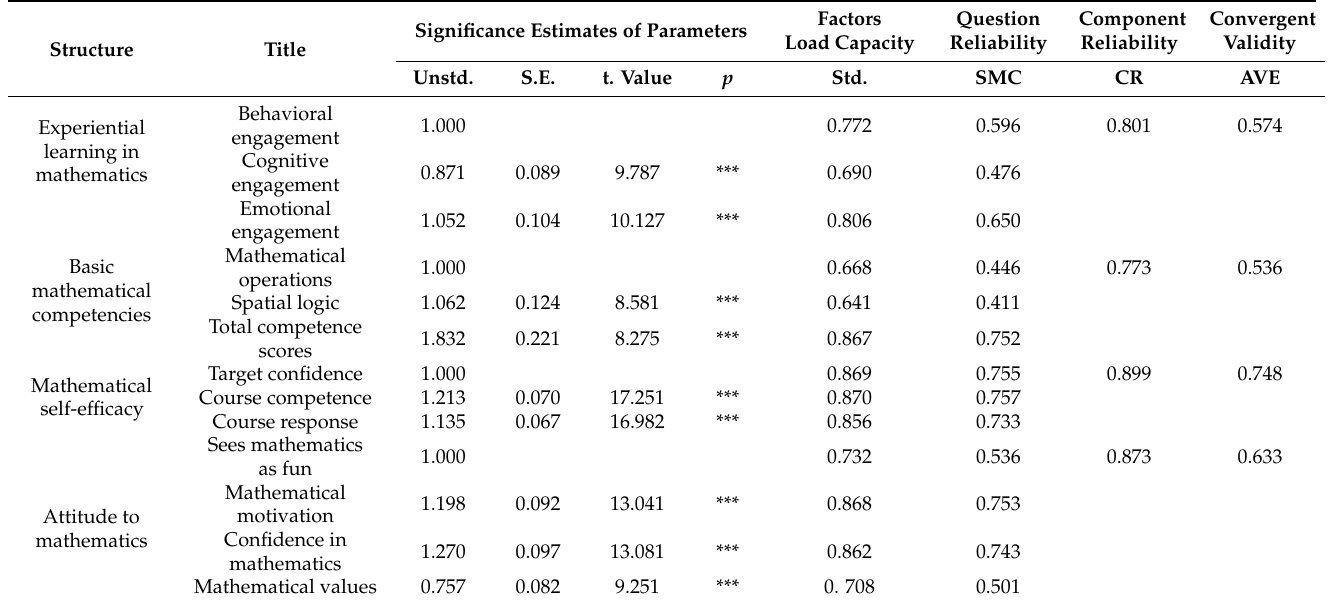
Table 1. Confidence analysis of potential conformations.